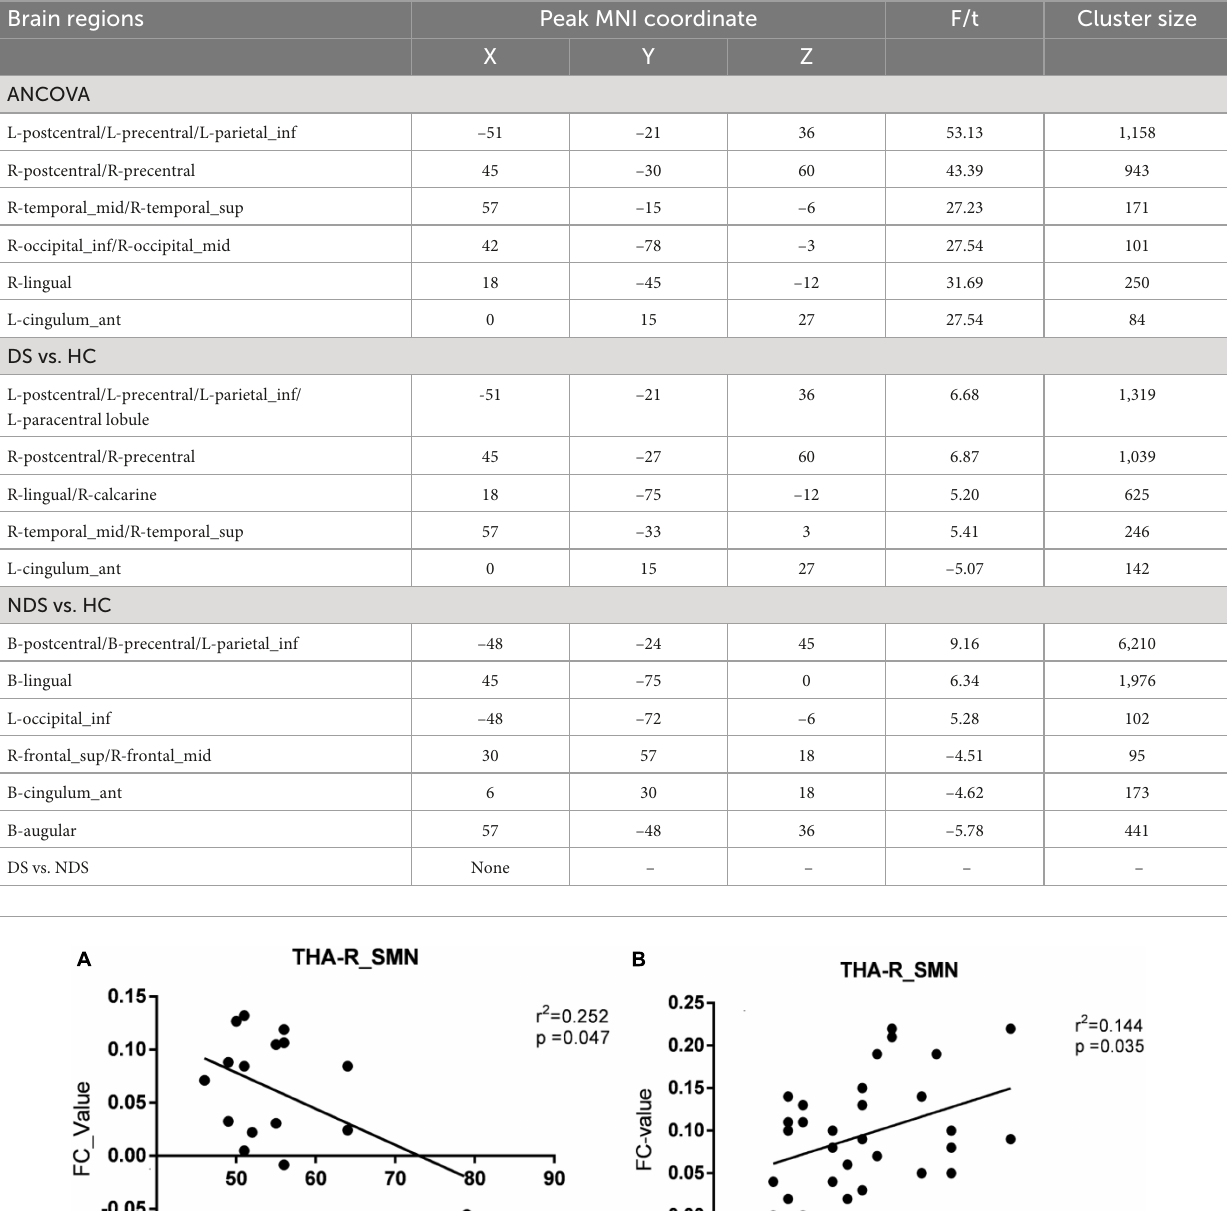
TABLE 3 Altered regions of functional connectivity (FC) analysis based on the region of interest (ROI) of right thalamus (THA-R). Brain regions Peak MNI coordinate F/t